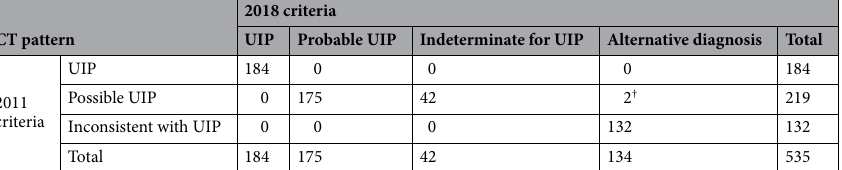
Table 2. Difference in categorization of fibrosing interstitial lung disease based on 2018 and 2011 diagnostic criteria. CT computed tomography; UIP usual interstitial pneumonia. † Two patients classified as having possible UIP on 2011 criteria showed ancillary findings, including pleural effusion and thickening or dilated esophagus and classified as having a CT pattern of alternative diagnosis on 2018 criteria.